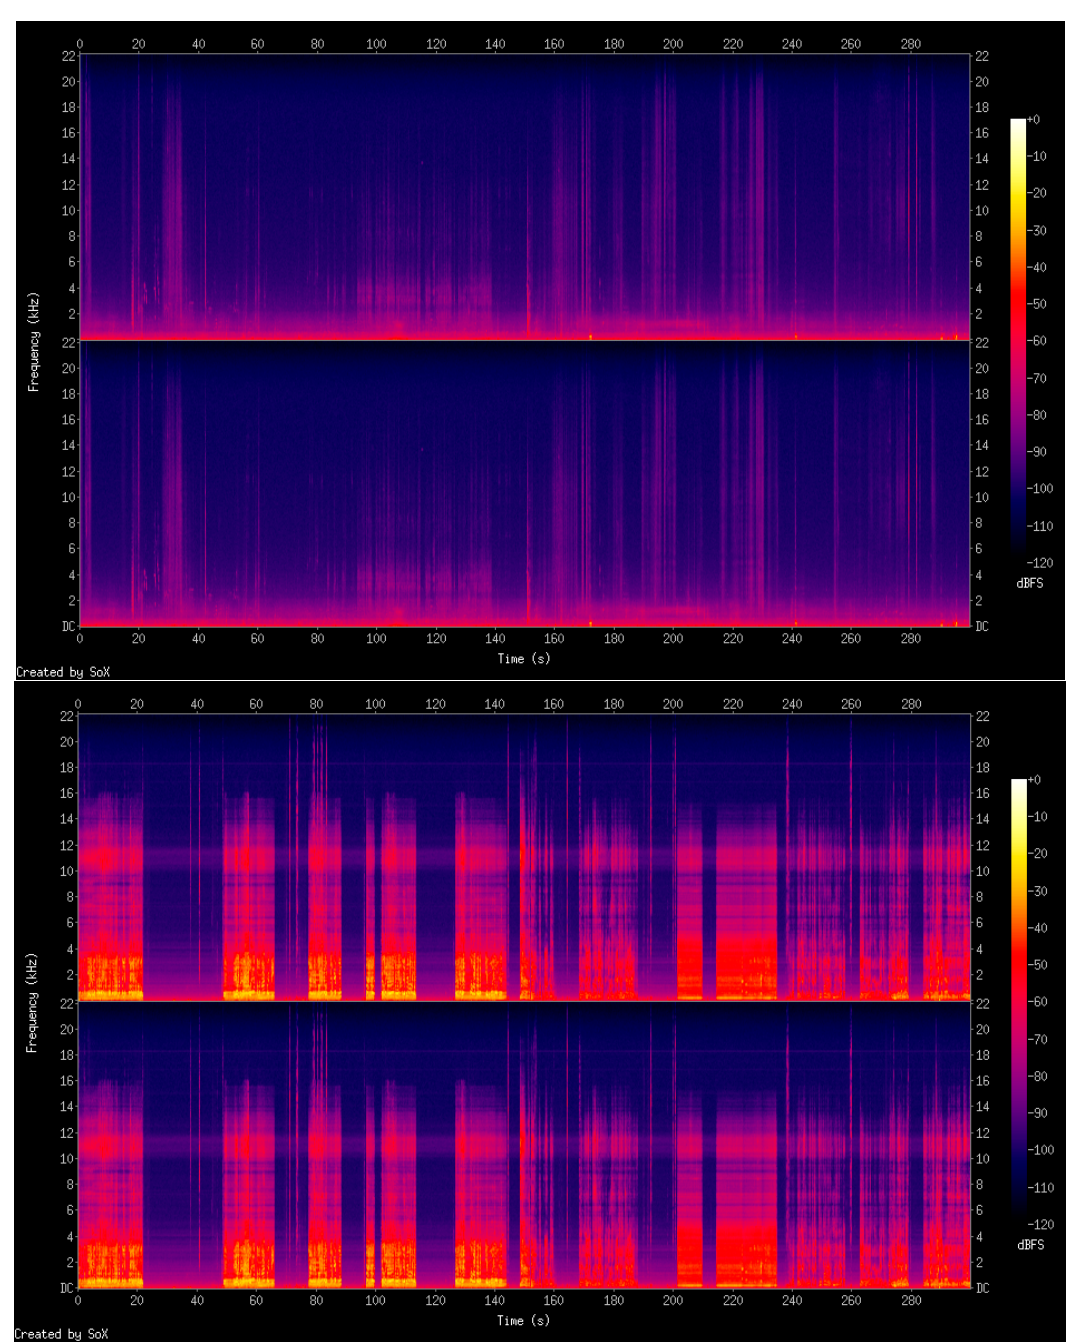
Figure 2. Spectrograms of the silent room ( upper figure —peak level dB was − 13.40) and the noisy room ( bottom figure —peak level dB was − 0.56).